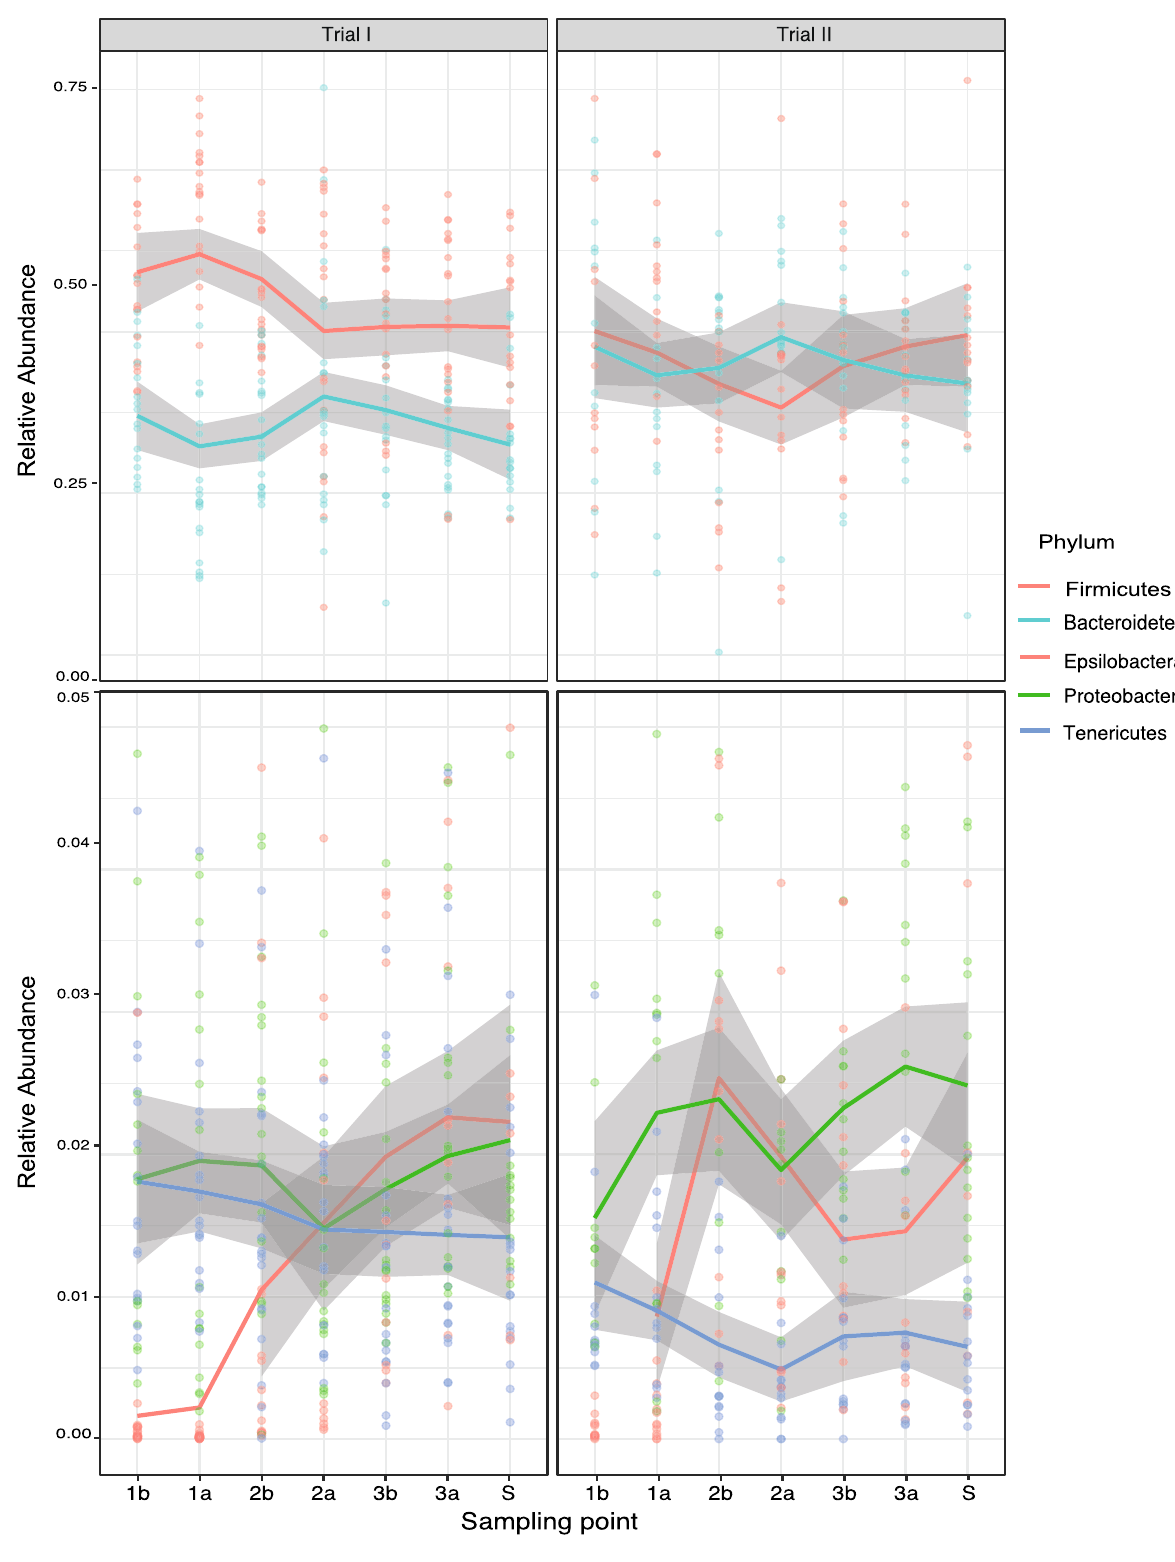
Figure 4. Relative abundance of dominant phyla identified in the microbiome of cecum of broilers. Results are presented discriminated by trial over time, shown as dose days. Sample days are indicated with the nomenclature of the dose number followed by the letter a or b for samples taken before and after the delivery of the treatments, respectively. The results at slaughterhouse are indicated as (S). Upper and lower panels show the range of abundance of Firmicutes and Bacteroidetes compared to other phyla. The color gray indicates the standard deviation of the mean abundance. This figure was generated using Phyloseq package in R v 1.2.5 (https:// www.r- proje ct.